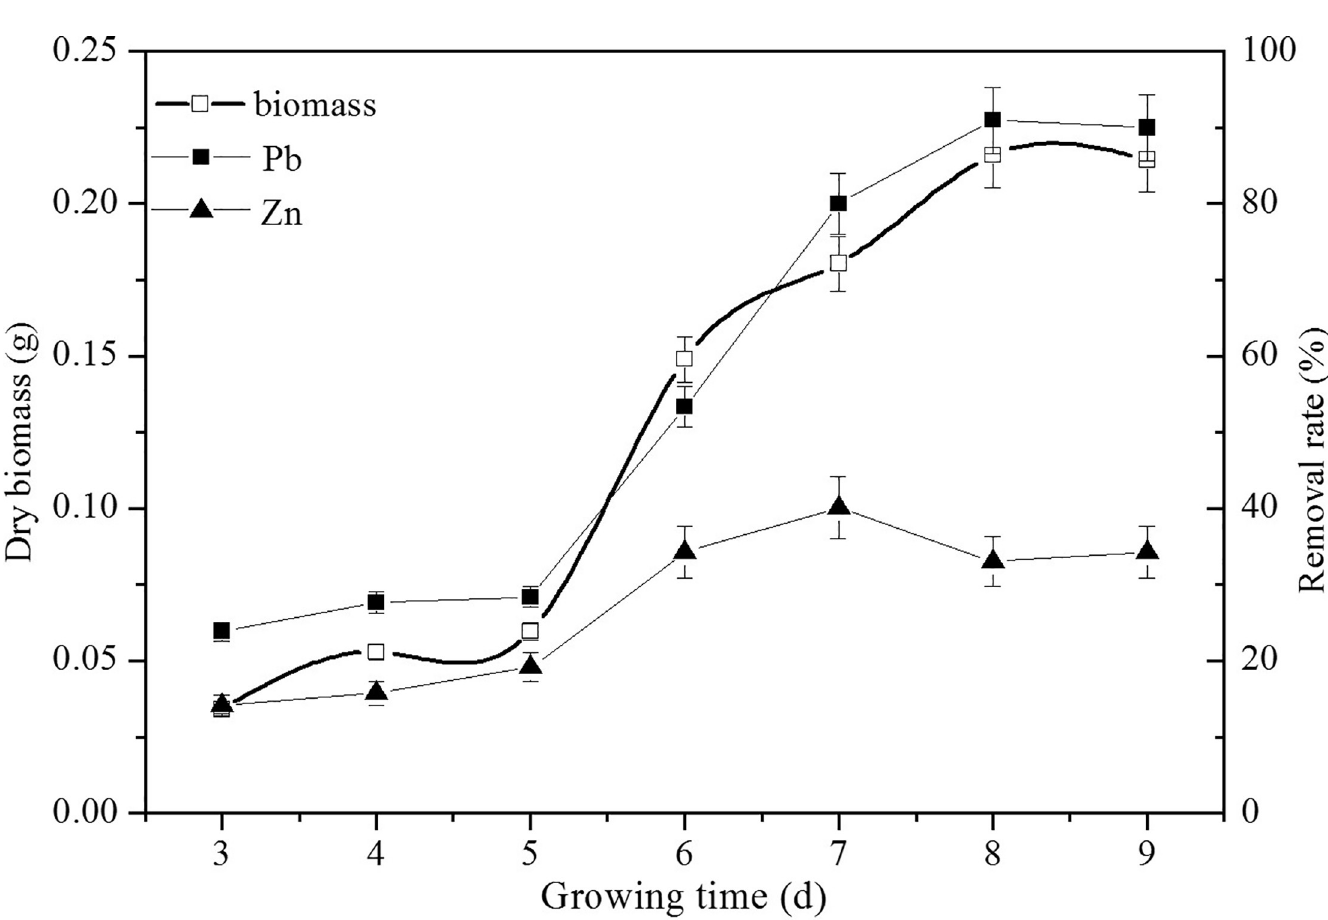
Fig 4. The effects of growth time on biosorption. Biosorption conditions: initial pH = 4, initial Pb(II) and Zn(II) concentration in solution 250 mg L -1 , initial biomass does 2mL/L, temperature 30˚C. (Error bar represents means ± SE, P < 0.05, and n = 3).